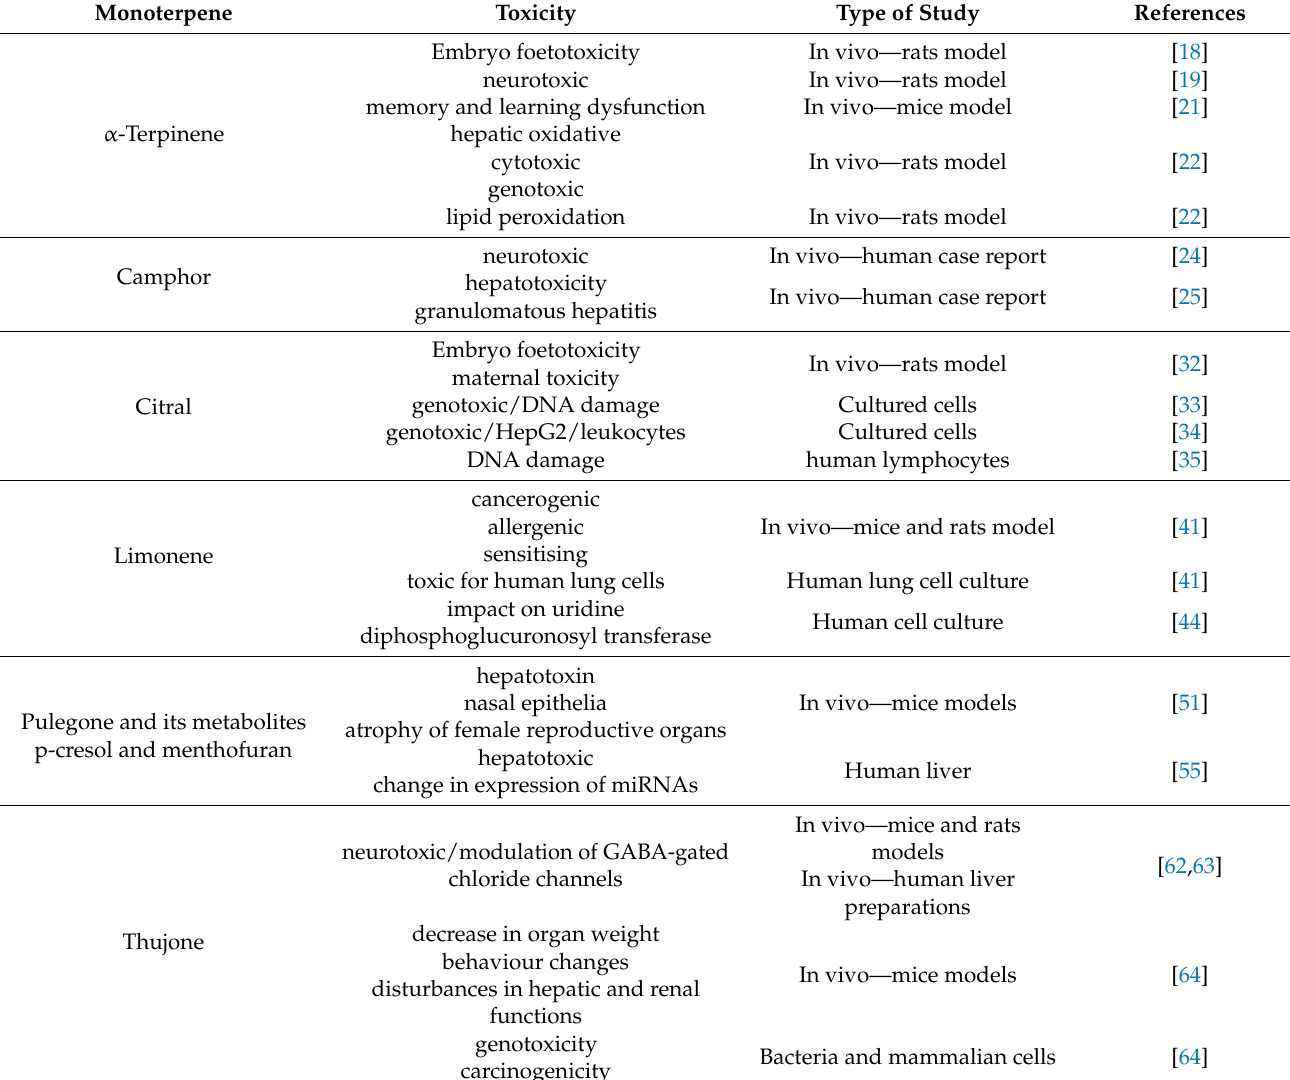
Table 1. Toxicity of selected